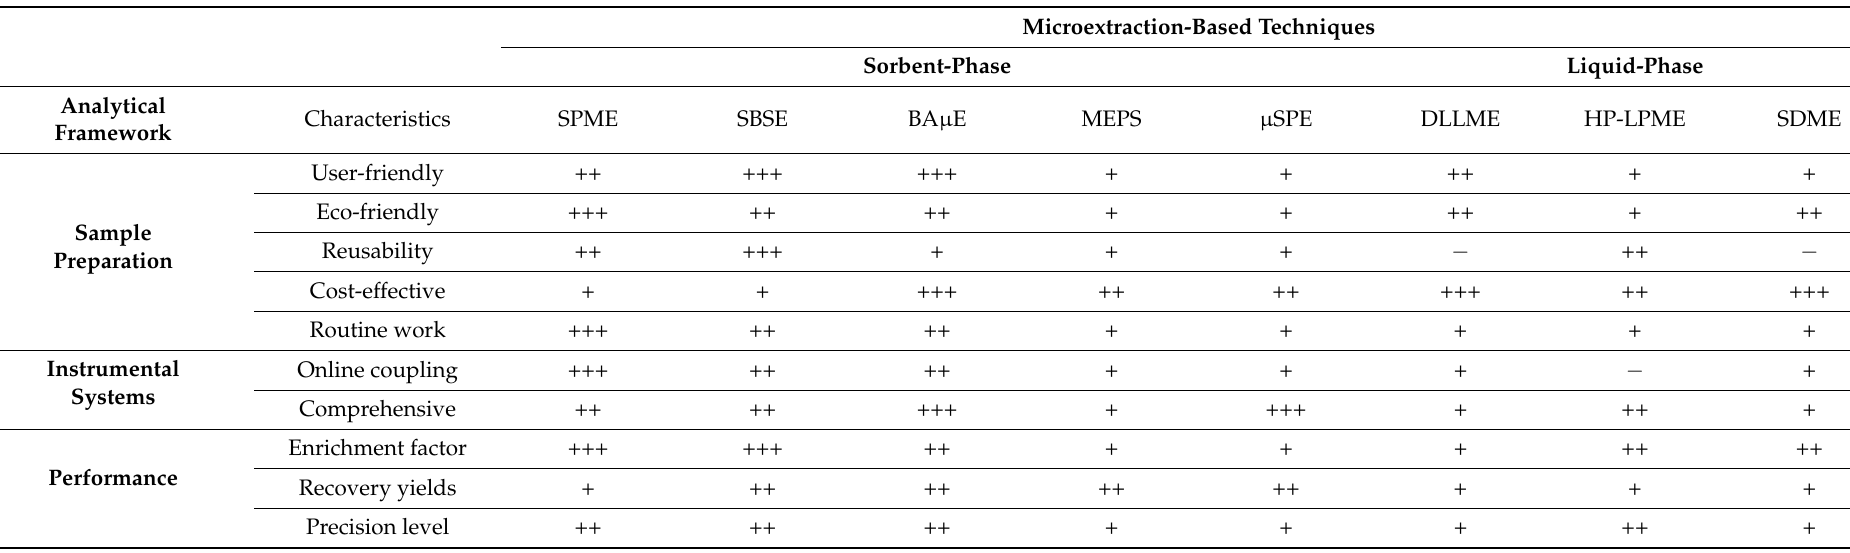
Table 8. Comparison of the main characteristics of the top-eight most frequently applied microextraction-based techniques for screening-controlled drugs in the forensic